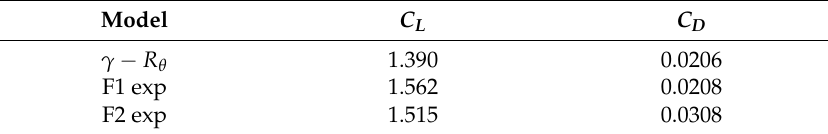
Table 7. Lift and drag at α = 13.1